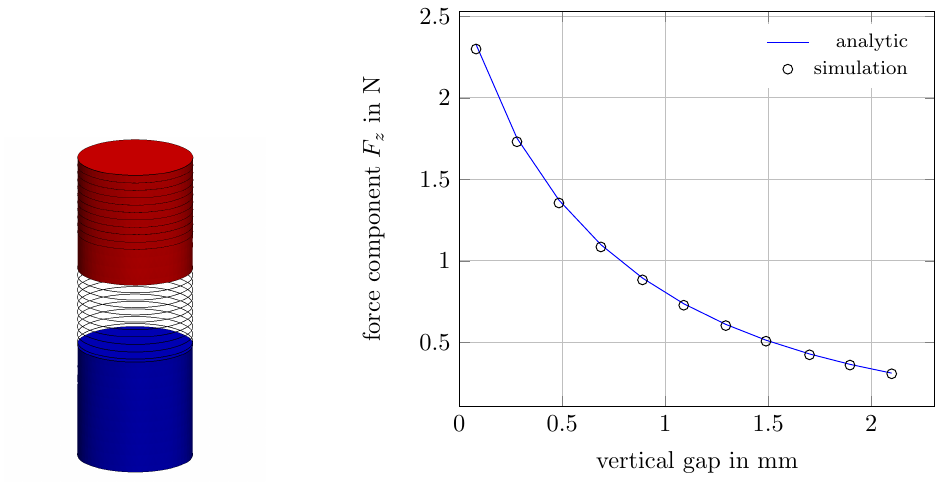
Figure 5. Two axis-aligned cylindrical permanent magnets. Position of the magnets where the red is shifted through various positions in z -direction ( left ). Analytic and simulated force component F z ( right